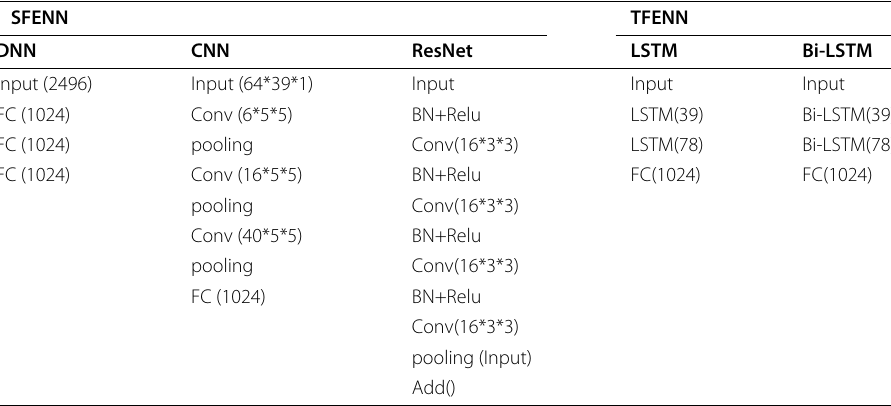
Table 3 PSTNN structure design